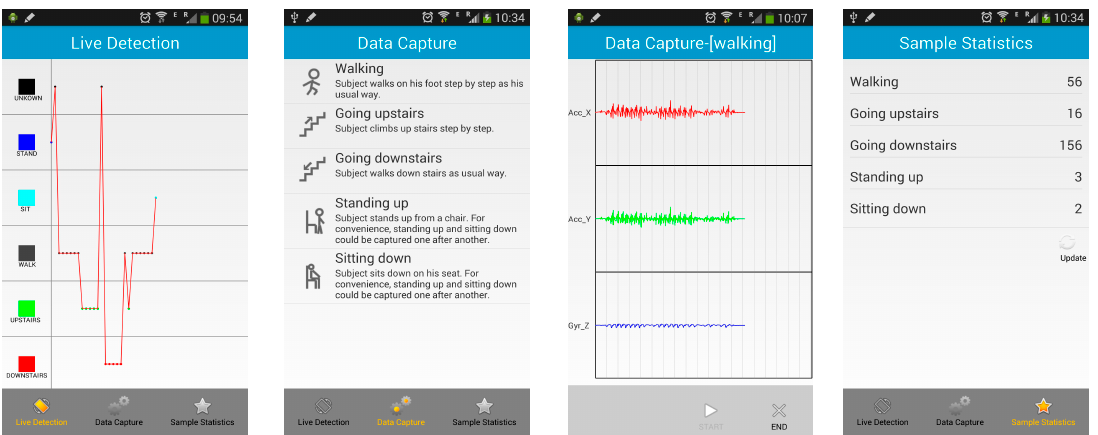
Figure 5. Screenshots of Live Detection System.